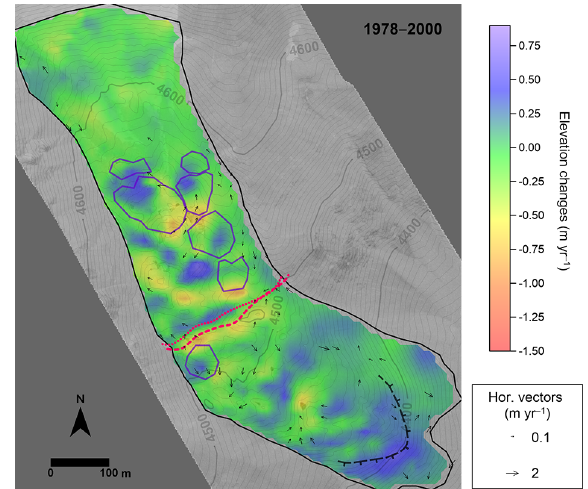
Figure 11. Horizontal displacements at the surface of Presenteser- acae between 1955 and 2000. The position of the base of the front at the two dates is indicated with dashed lines, as in Fig. 7; push moraine ridges in the upper part are also indicated. The background of the map is the 2000 orthophoto.